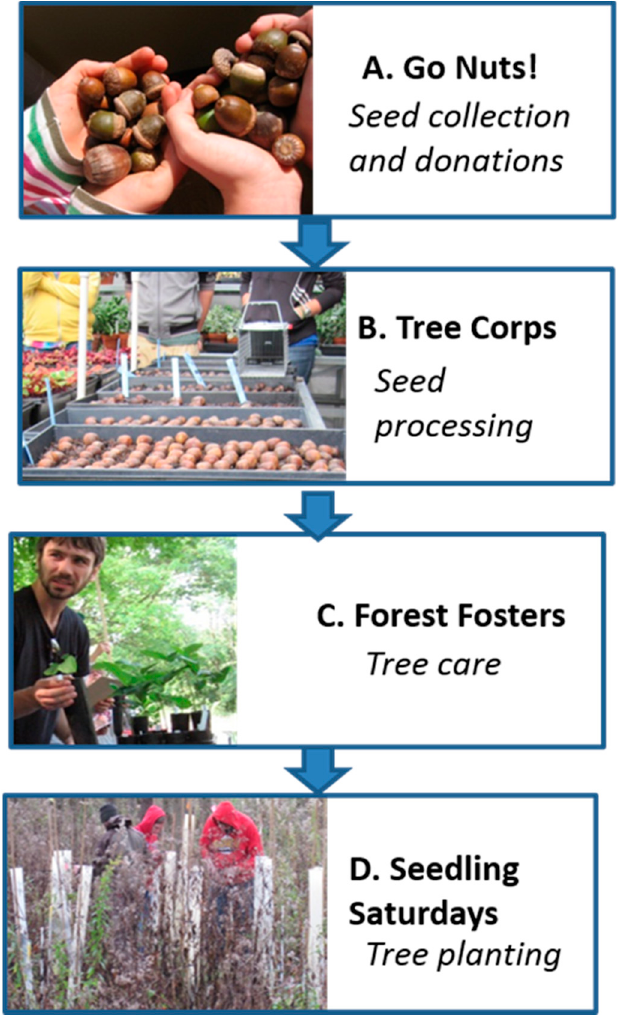
Figure 1. Vegetation processes and volunteer programs developed by the Five Rivers MetroParks (FRMP; Dayton, Ohio) in response to the mass mortality of ash from emerald ash borer. The program starts with donations of seeds from the community in the “Go nuts!” phase ( A ), then trains community members to process seeds and prepare for stratification in “Tree Corps” ( B ). During “Forest Fosters” ( C ), community members were encouraged to take seedlings home and care for them over the summer before returning for “Seedling Saturdays” ( D ), where they planted trees in the target restoration areas.